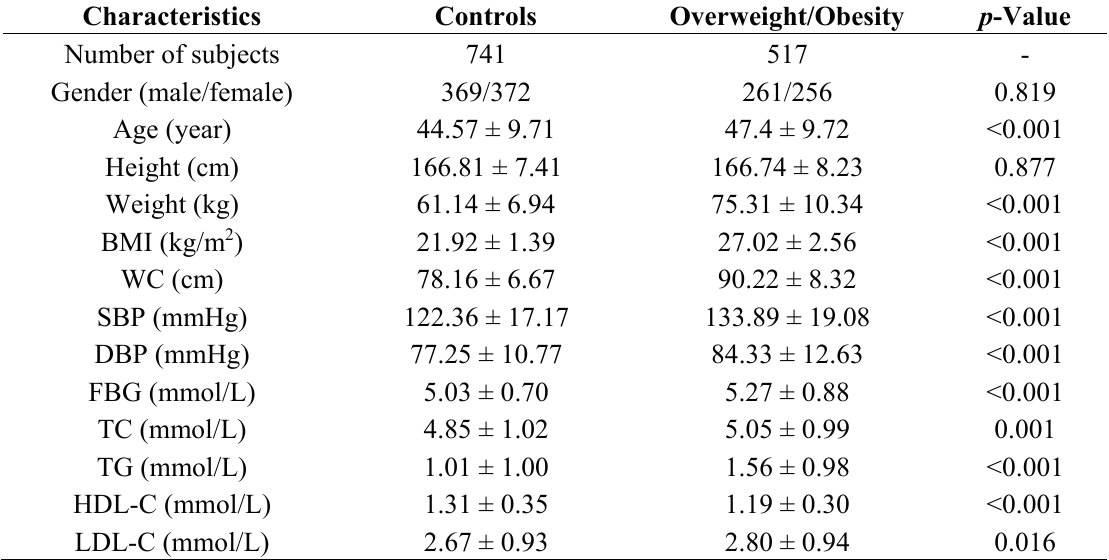
Table 1. Anthropometric and clinical characteristics of the study subjects. Characteristics Controls Overweight/Obesity p